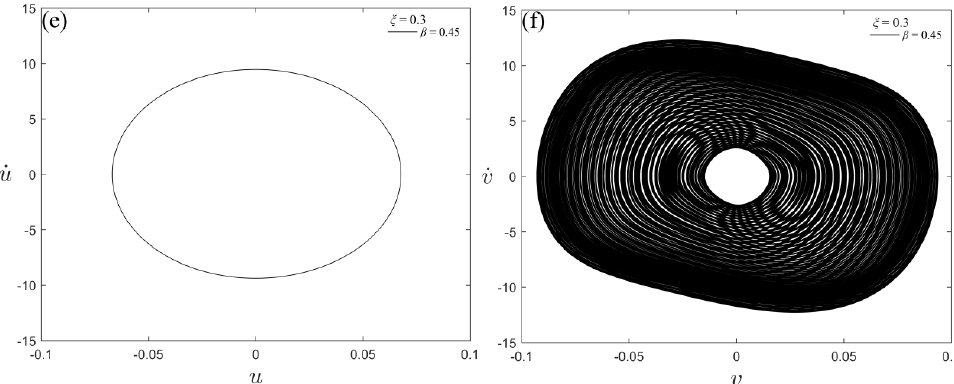
Figure 13. Phase diagrams of the beam without NES and NES in the beam–NES system for different crack parameters; ( a ) phase diagram of beam without NES for β = 0.15, ( b ) phase diagram of NES for β = 0.15, ( c ) phase diagram of beam without NES for β = 0.35, ( d ) phase diagram of NES for β = 0.35, ( e ) phase diagram of beam without NES for β = 0.45, ( f ) phase diagram of NES for β = 0.45. It can be seen from Figure 13 that the phase diagram of the beam without NES is elliptical, and the area of the phase diagram increases with the increase in the position ratio. The phase diagram of NES in the beam–NES system is manifestly different, with the shape changed from an ellipse to a ring. With the increase in the position ratio, the area of the small white circle gradually decreases and the area of the black ring increases. The area of the small white part is denoted as S s and the area of the black ring, which is en- closed by the outermost black contour line and the boundary line of the small white circle, is S l . The changes in S s and S l with β and ξ are shown in Figures 14 and 15, respectively. In order to verify the feasibility of crack identification using S s and S l , four groups of param- eters are selected. The values of S s and S l under different crack parameters are given in